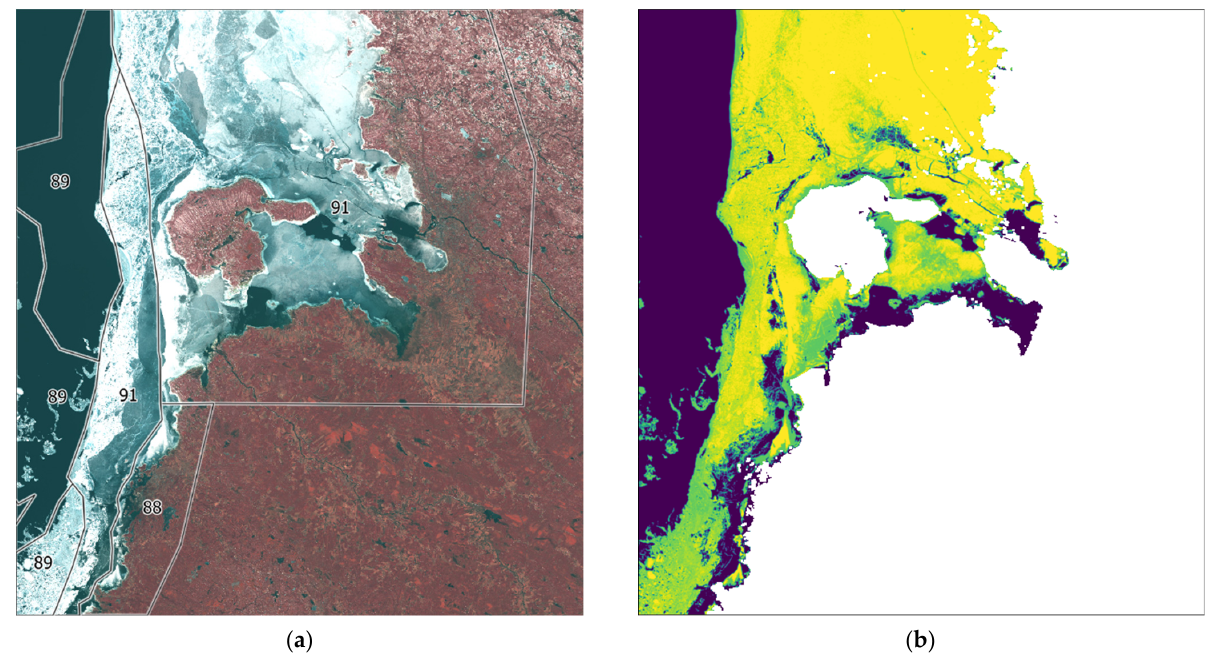
Figure 15. ( a ) Landsat-8 false color for 23 April 2019; BSH ice chart for 24 April 2019; ( b ) ICESOD classification.